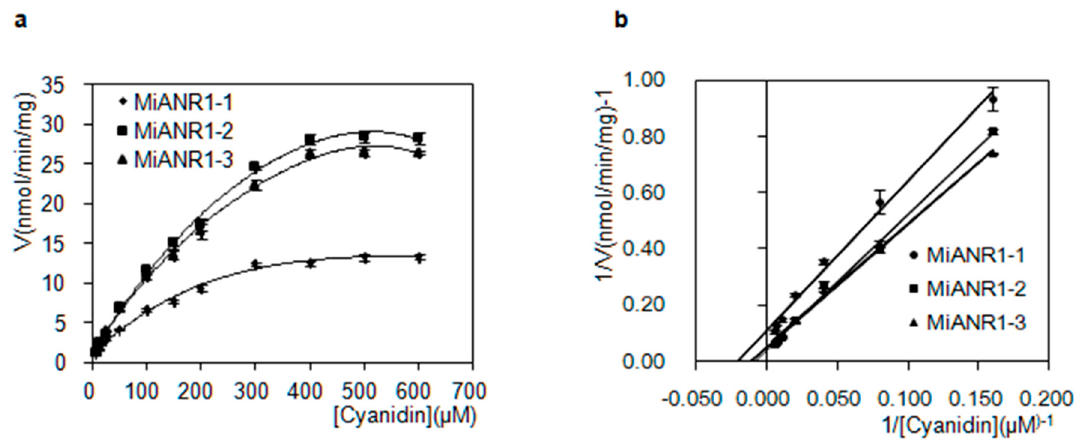
Figure 7. Kinetics of MiANR1-1, 1-2 and 1-3 with cyanidin. The initial velocity was expressed with nanomolar products produced from substrates per min by per milligram of ANR in the presence of NADPH (1 mM). Plots of initial velocity (V) versus cyanidin for MiANR1-1,1-2 and 1-3 ( a ) and double-reciprocal plots of 1/V versus 1/(cyanidin) for MiANRs ( b ). Products of cyanidin were calculated as ( − )-epicatechin by using an ( − )-epicatechin standard.